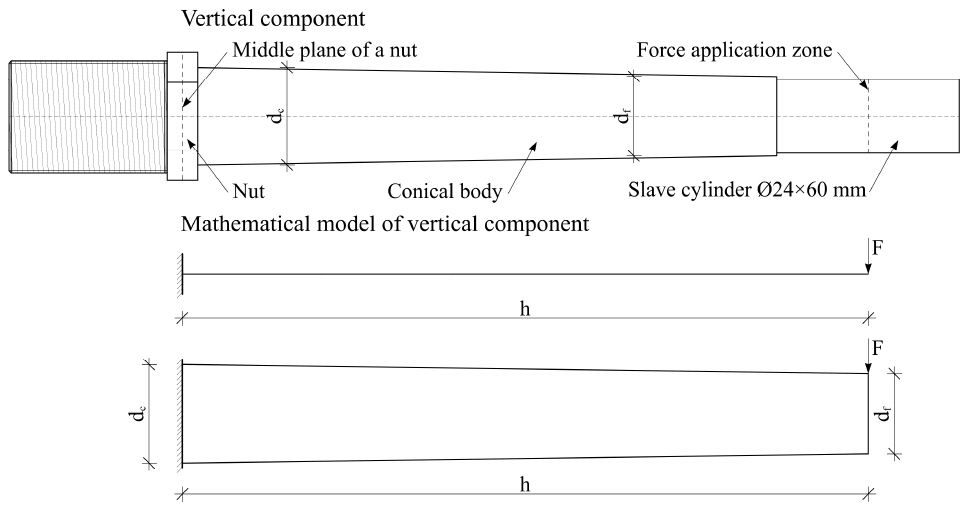
Figure 10. A mathematical model for the application of the semi-analytical solution for the force– displacement relationship of the vertical component of the energy dissipation